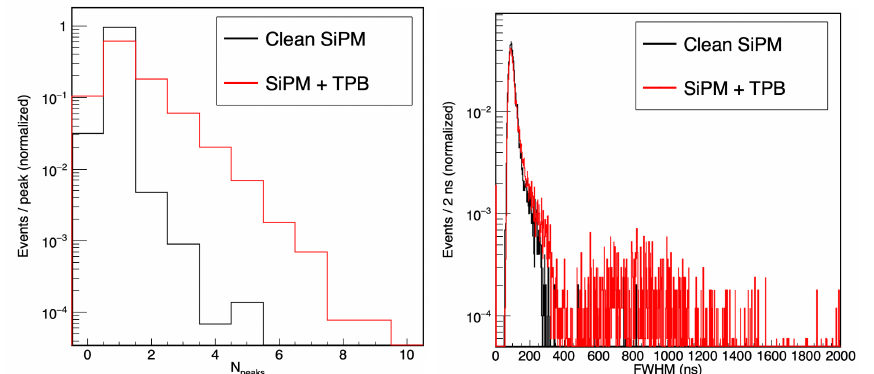
Figure 6. The number of pulses with peak amplitudes above 30 mV per triggered event ( left ) and the full width at half-maximum of all the pulses in the 15 µ s readout window ( right ) for the clean and TPB-coated SiPMs.